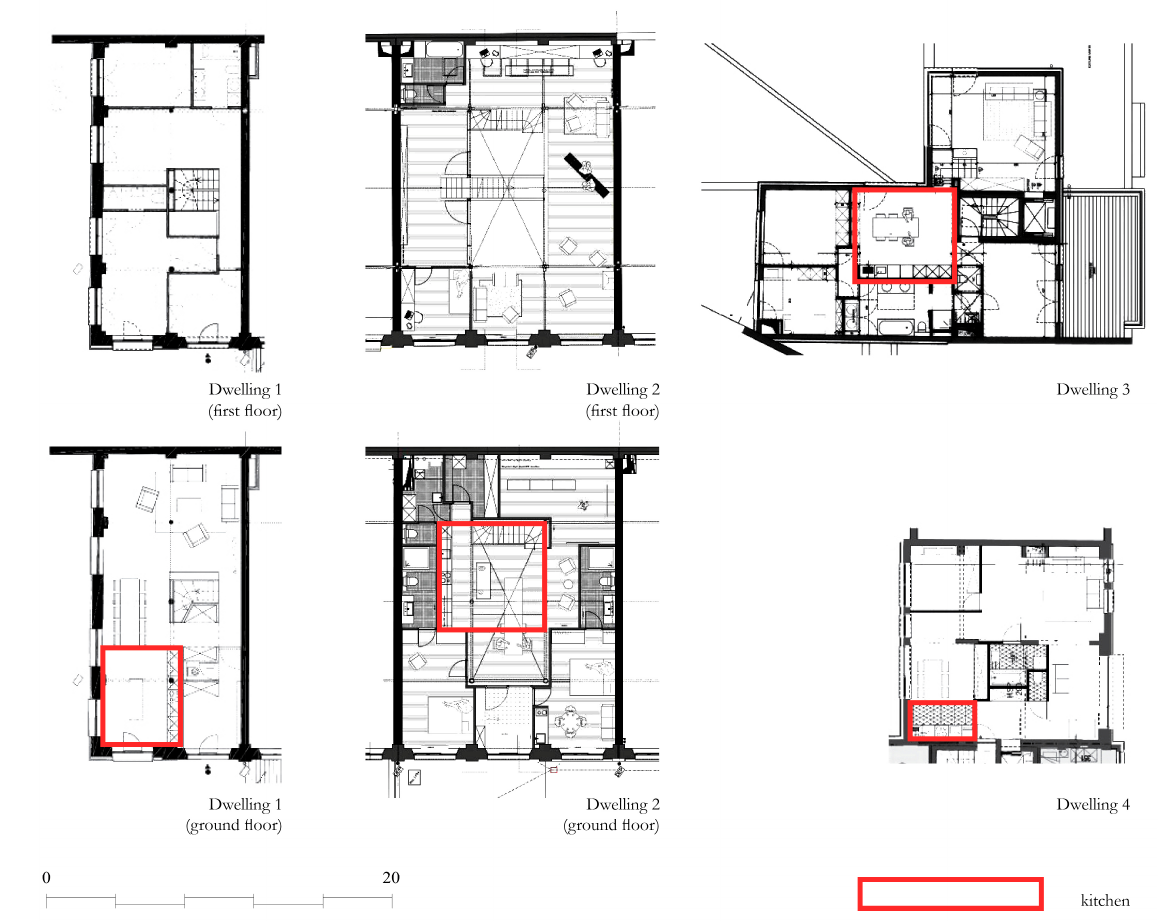
Figure 5. Casa Nova apartments, kitchen position (drawn by the authors, 2019).